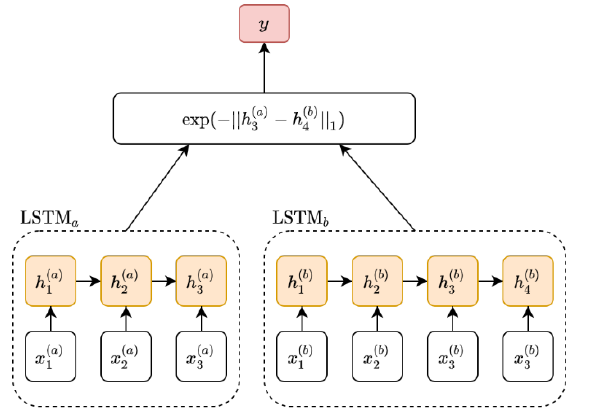
Fig. 2. Illustration of Manhattan LSTM architecture